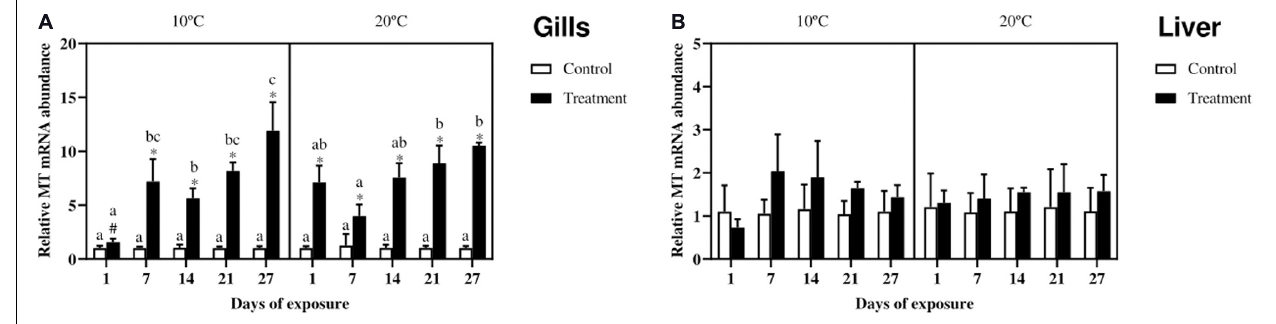
FIGURE 4 | Relative metallothionein (MT) mRNA abundance in gills (A) and liver (B) of Cyprinus carpio exposed to Cu, Zn, and Cd mixtures for 27 days. Mean ± SD, N = 4. Asterisks ( ∗ ) indicate differences between control and metal treatment at each sampling day, the hash (#) indicate differences between the same groups (both control and metal treated) at different temperatures, and lowercase letters indicate significant differences of the same group among sampling days at each temperature ( p <